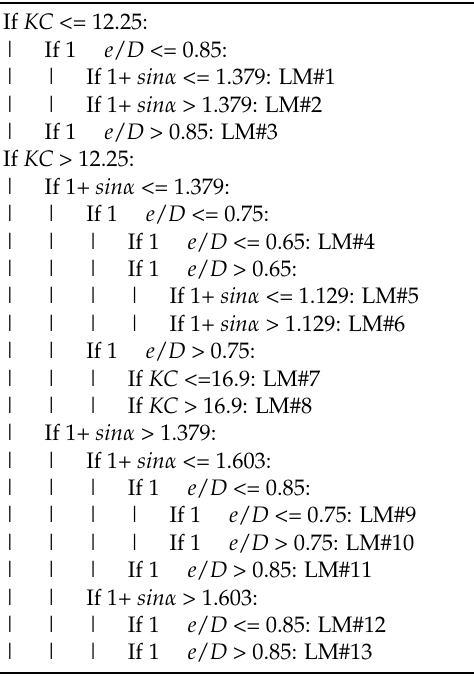
Table A8. List of explored rules returned by M5MT model to predict V ∗